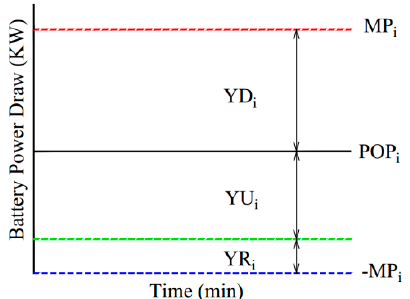
Figure 1. Relationship between preferred operating point (POP) and ancillary services capacities of a certain battery.